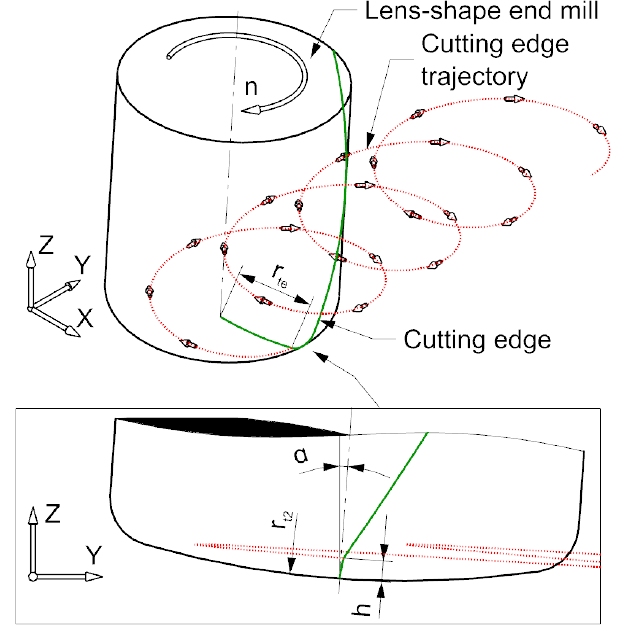
Figure 3. The trajectory of the point located on the edge of the lens-shaped end-mill.